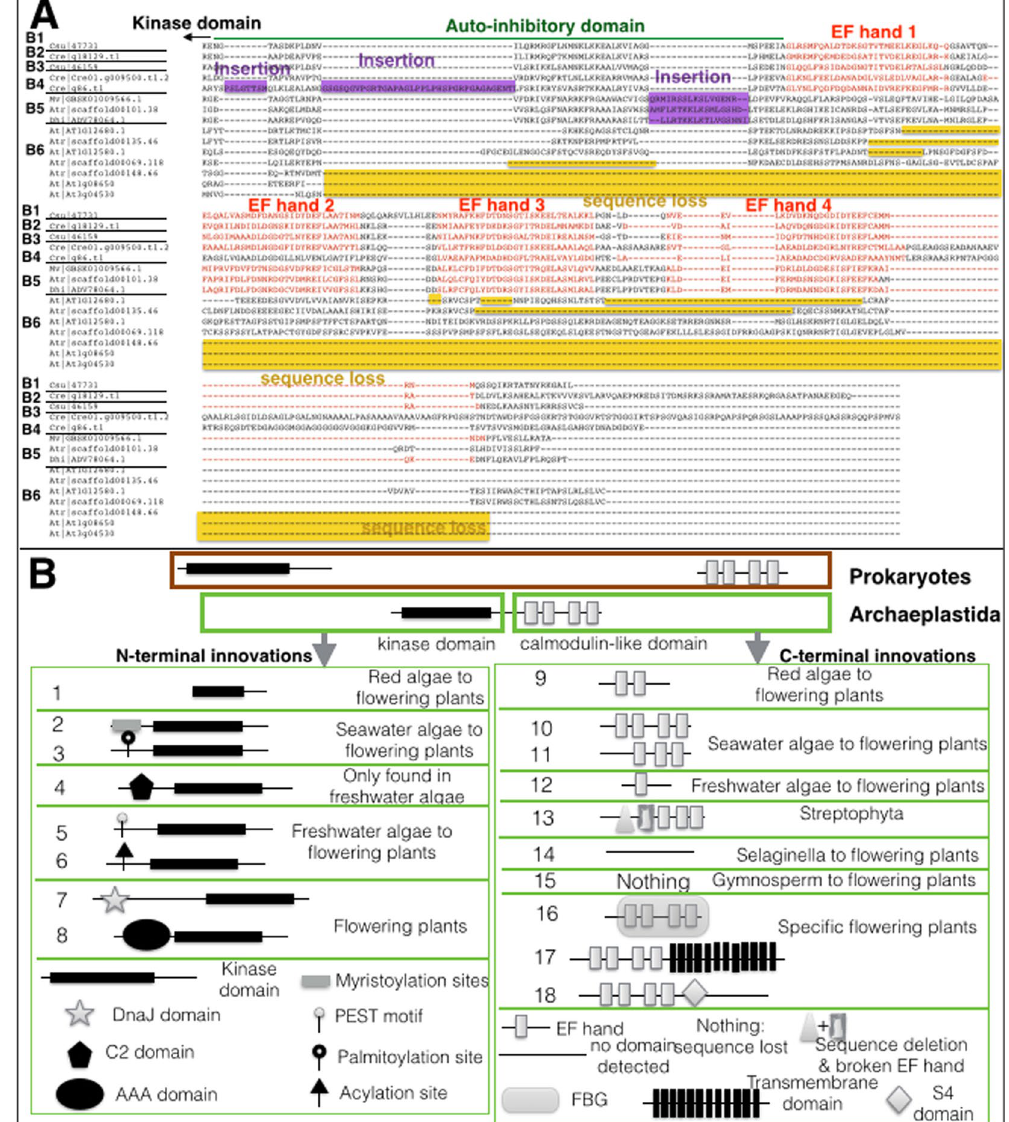
Figure 3. Structural innovations at the N-terminal and the C-terminal of calmodulin fused kinase proteins. ( A ) Domain changes in the C-terminal of subfamily B caused by sequence insertion (purple) and deletion (yellow). ( B ) The 18 representative structural innovations and modifications in both N- and C-terminal of